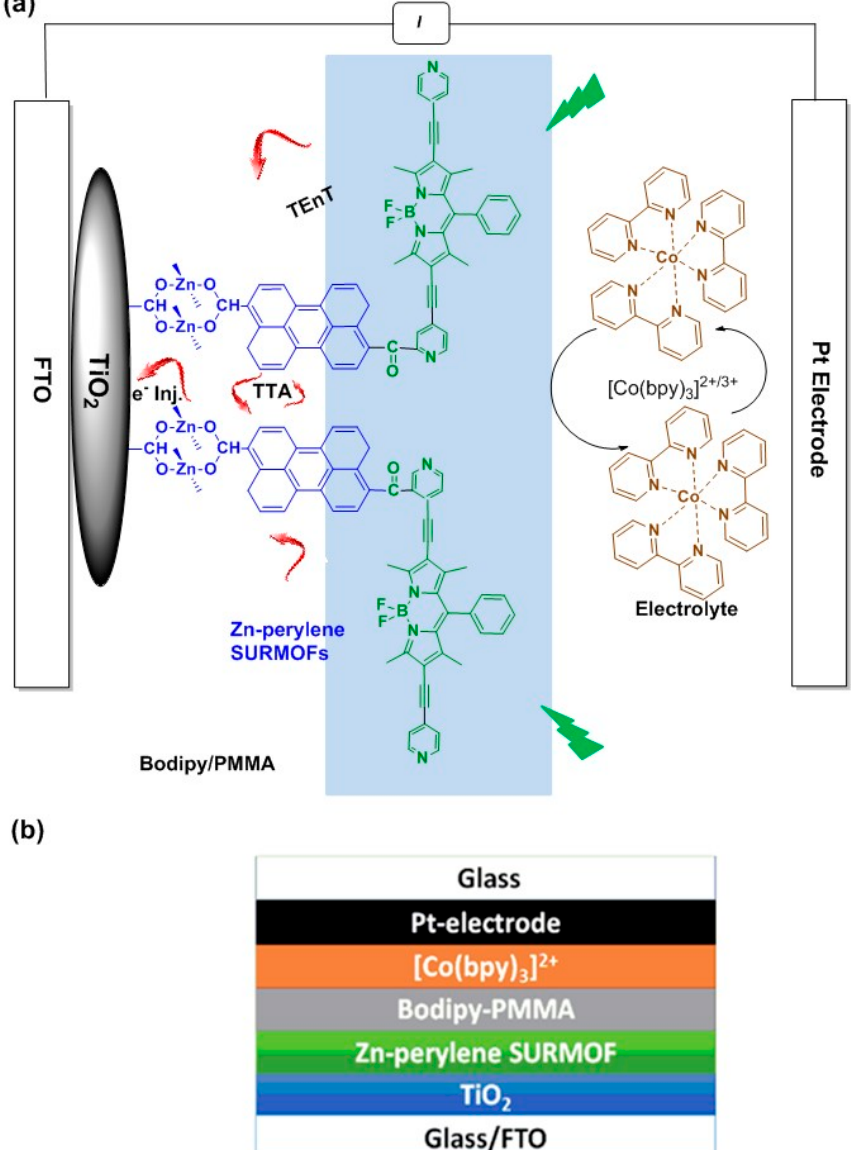
Figure 2. ( a ) Schematic representation of Zn-perylene SURMOF on TiO 2 and Bodipy/PMMA layer; ( b ) the architecture of Zn-perylene SURMOF-based dye sensitized solar cell.